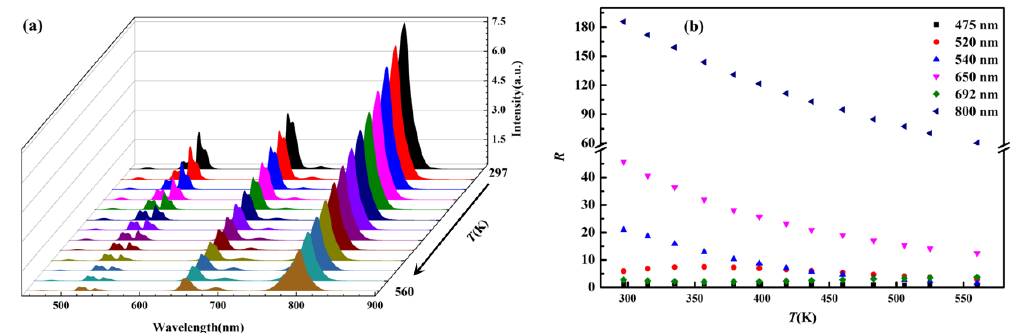
Figure 5. ( a ) Up-conversion luminescence of the sample at different temperatures; ( b ) temperature-dependent integrated intensity of the emissions located at different wavelengths.